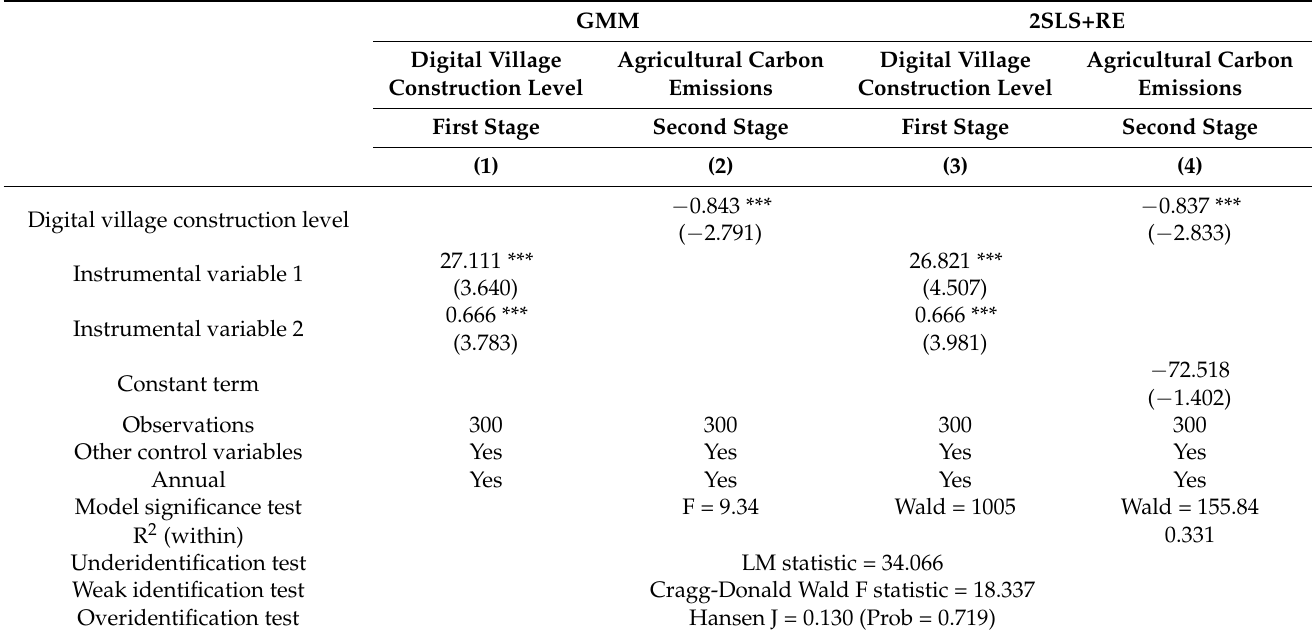
Table 9. Regression results of the instrumental variables